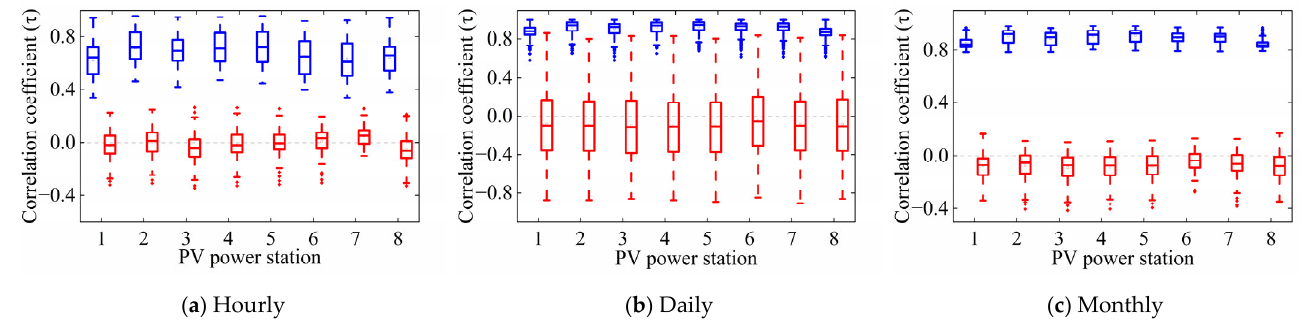
( c ) Monthly Figure 4. The fi rst type of complementary indicator under di ff erent time scales (the blue box represents the solar-solar mode, and the red box illustrates the solar-wind mode).